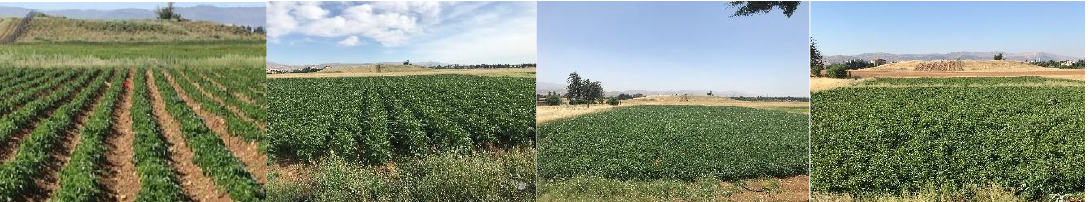
Figure 5. Time series of potential water requirements, Kcb, and reference evapotranspiration for the AgSAT validation experiment at AREC. Kcb matched well with FAO56 Kcb’s.